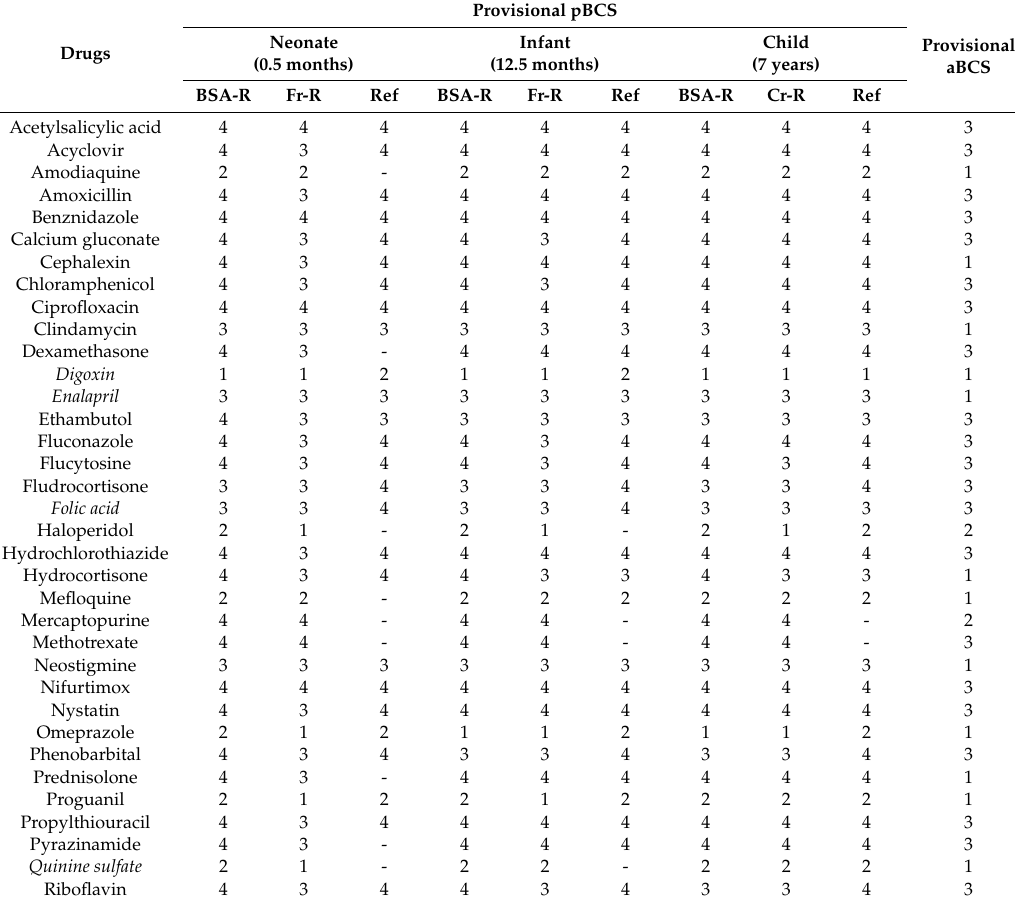
Table 3. Provisional pBCS classification of drugs with unfavorable changes with respect to adult BCS (aBCS). Drugs with unfavorable changes with the referenced dose dosage in all age stages are given in bold. Drugs in italics indicate changes in pBCS classification with the referenced dose not in all of the age stages. Abbreviations: BSA-R, body surface dosage; Fr-R, Fried’s Rule dosage; Cr-R, Clark’s Rule dosage; Ref, referenced dosage; aBCS, adult